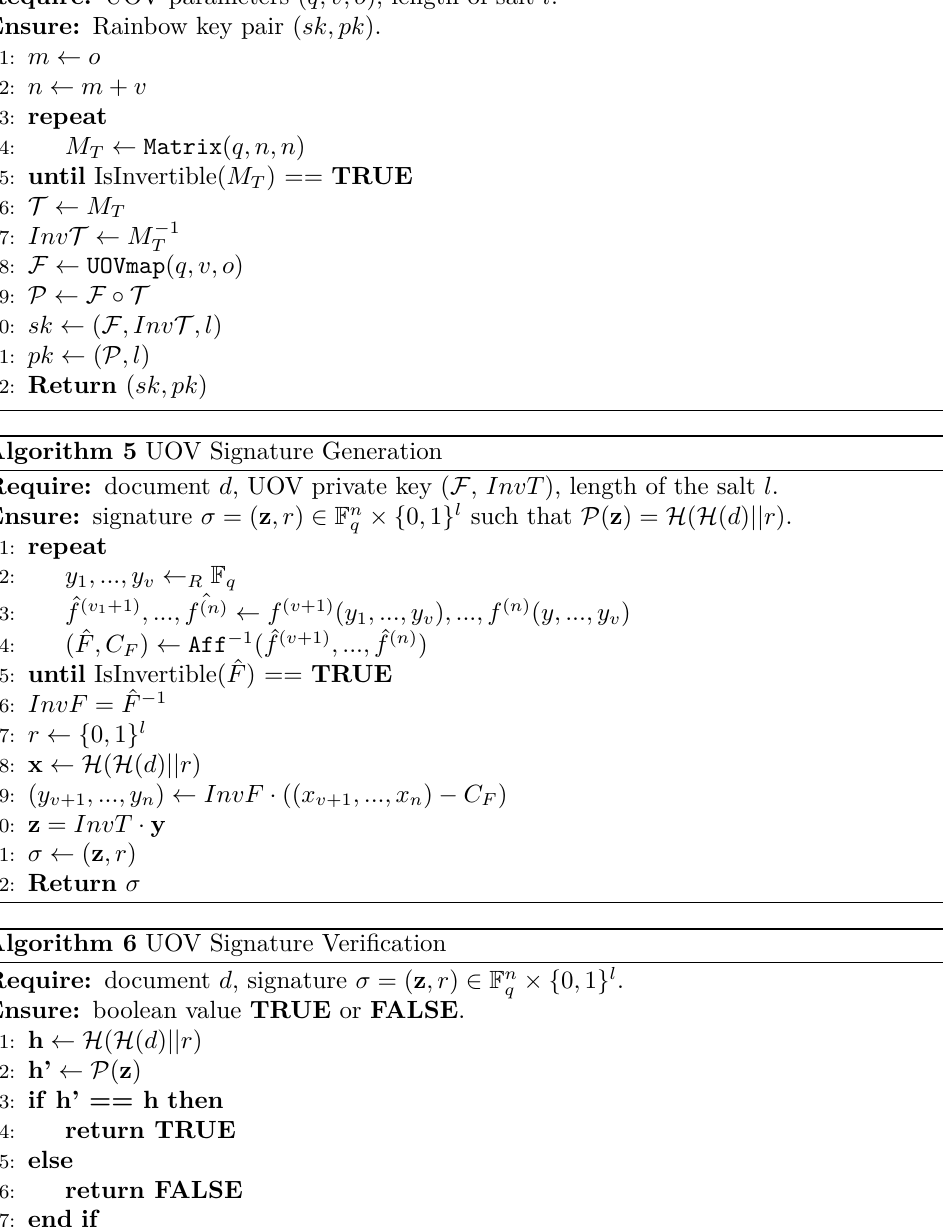
Algorithm 4 UOV Key Generation